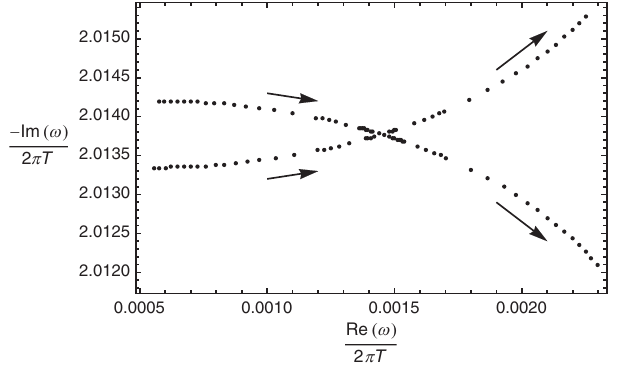
FIG. 2. Frequencies of the hydrodynamic and longest-lived infrared modes at T=m ¼ 10 − 3 , enlarging the region near ω 0 . The black dots are the numerical results (the bottom dots are the hydrodynamic mode, the top ones the longest-lived nonhydro- dynamic mode), the red lines show the dispersion relations extracted analytically from Eq. (14) for real values of k . The pole collision is not visible here as it happens at a complex value of k .